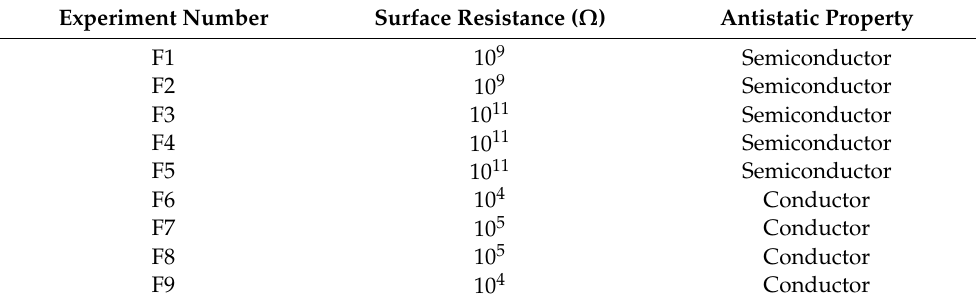
Table 3. Test results of the impedance and surface resistance of the pure and functional PU films. Experiment Number Surface Resistance ( Ω